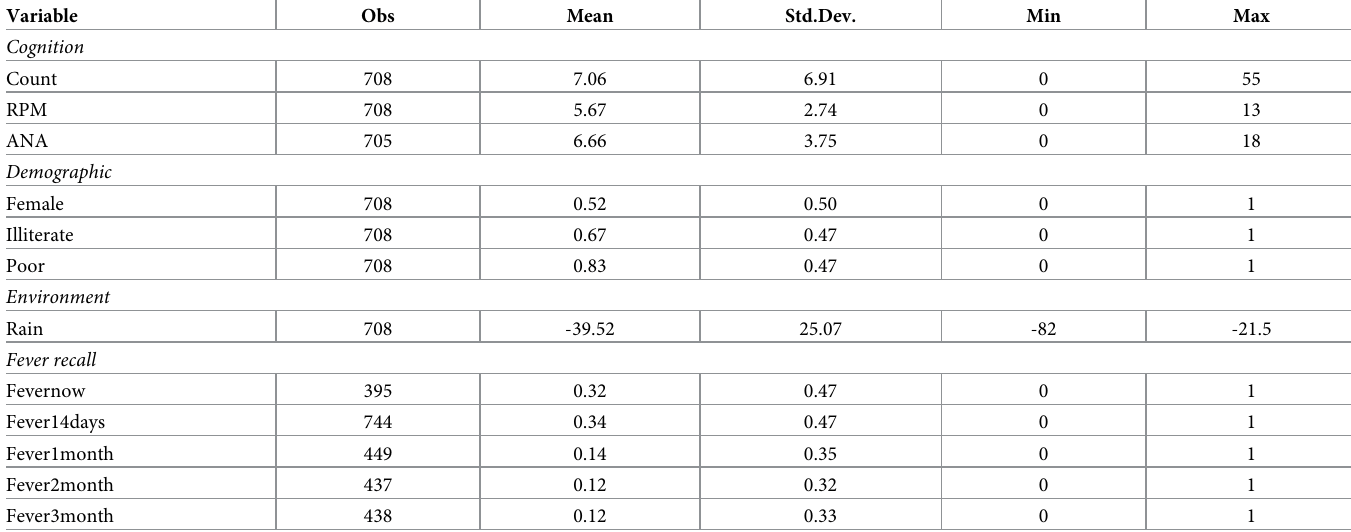
Table 1. Summary